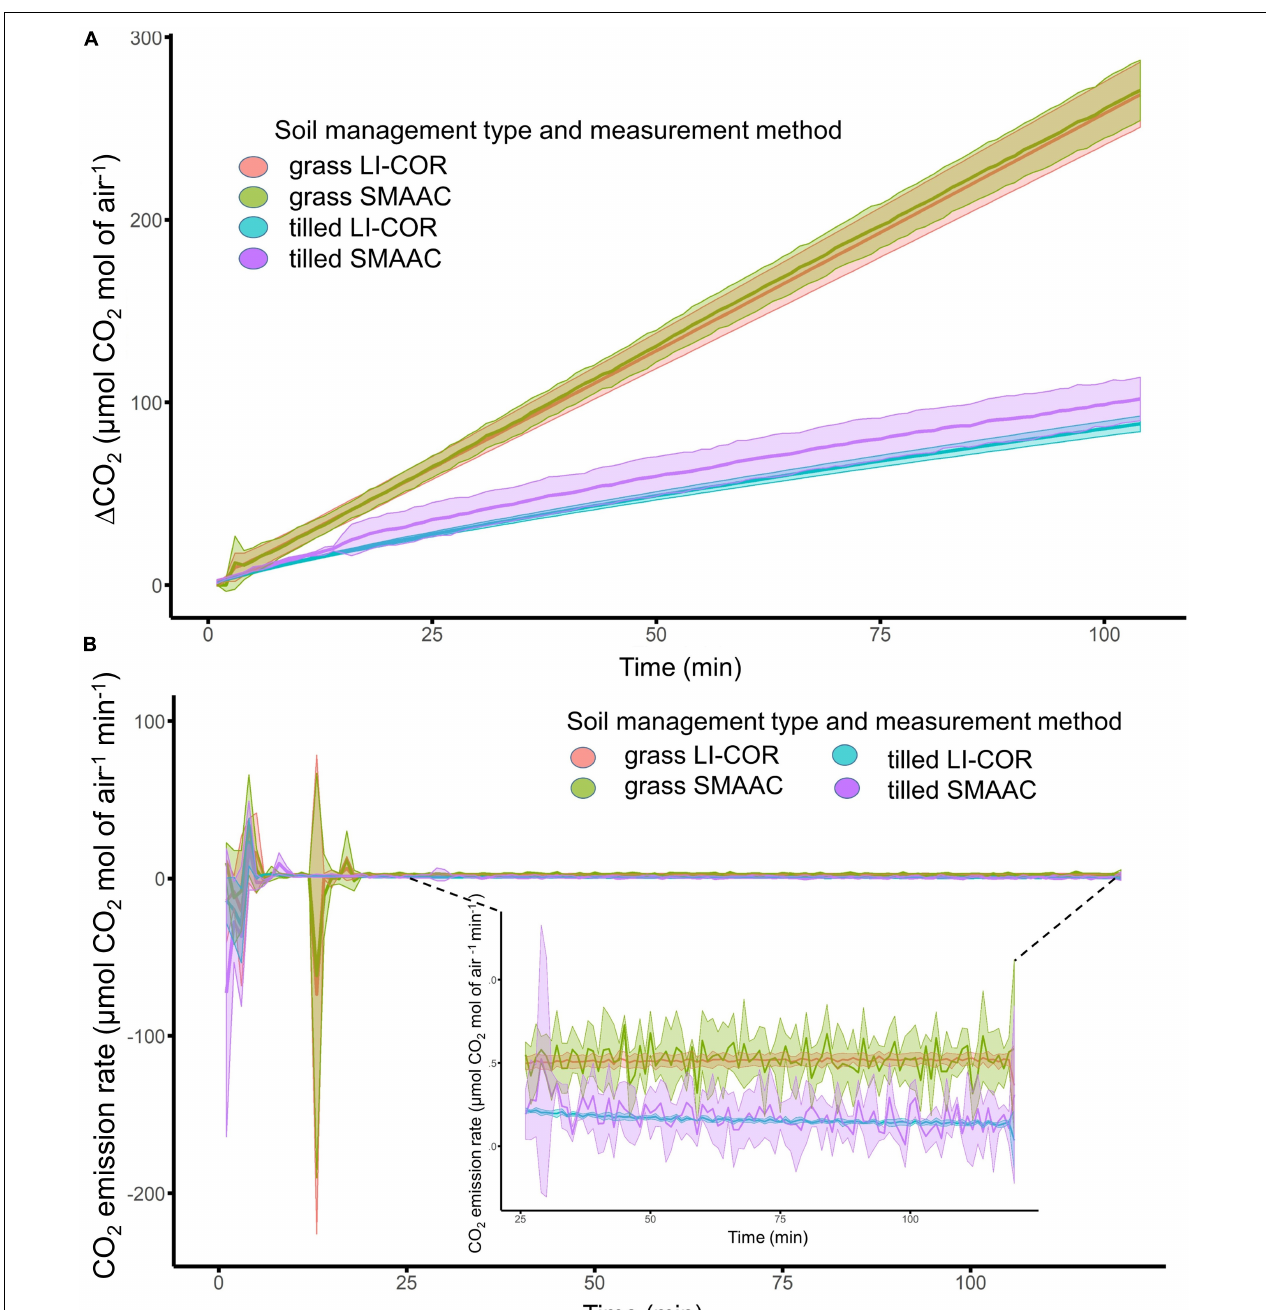
FIGURE 4 | (A) Laboratory measurement of change in CO 2 through time (min) for grass-covered and tilled soils, measured using a LI-COR 8100, and the SMAAC-Burst configuration. Solid lines represent mean values, and shaded areas represent standard deviations from the means. (B) CO 2 emission rates for grass-covered and tilled soils, measured using the LI-COR, and the SMAAC-Burst